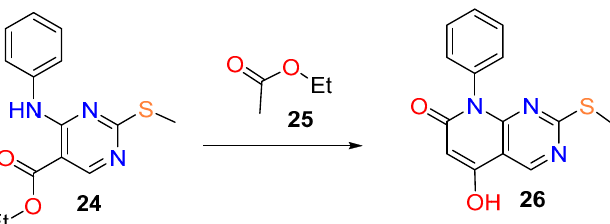
Figure 12. Synthesis of the 5-hydroxy substituted pyrido[2,3- d ]pyrimidin-7(8 H )-one ( 26 ) from pyrimidine ester ( 24 ).